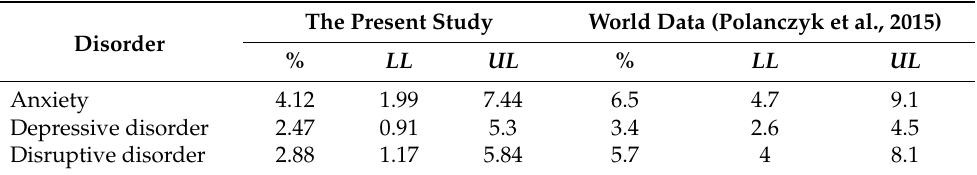
Table 7. A comparison of the prevalence of mental health indicators between the current Spanish sample and world